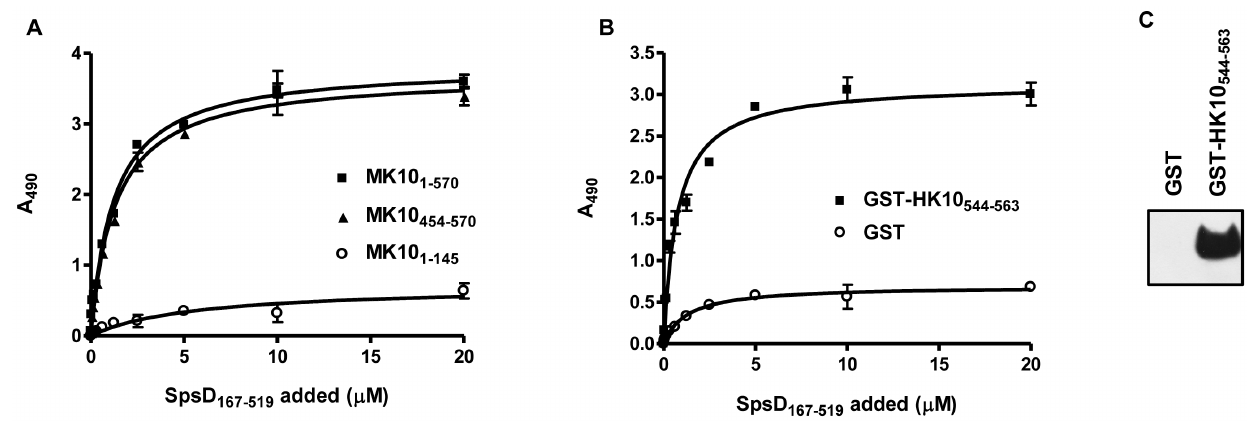
Figure 7. Binding of SpsD 167 – 519 to immobilized cytokeratin 10 proteins. (A), SpsD 167–519 was incubated in wells coated with recombinant mouse K10 1–570 , K10 1–145 and K10 454–570 . (B), SpsD 167–519 was added to ELISA wells coated with GST-human K10 544–563 , (HK10 544–563 ); or GST alone. Bound SpsD